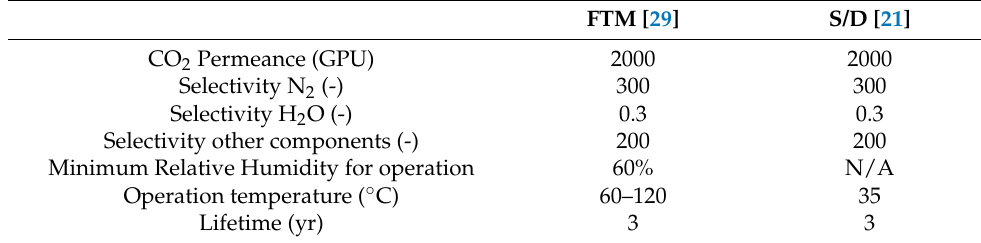
Table 2. Membrane characteristic used for the process simulation.